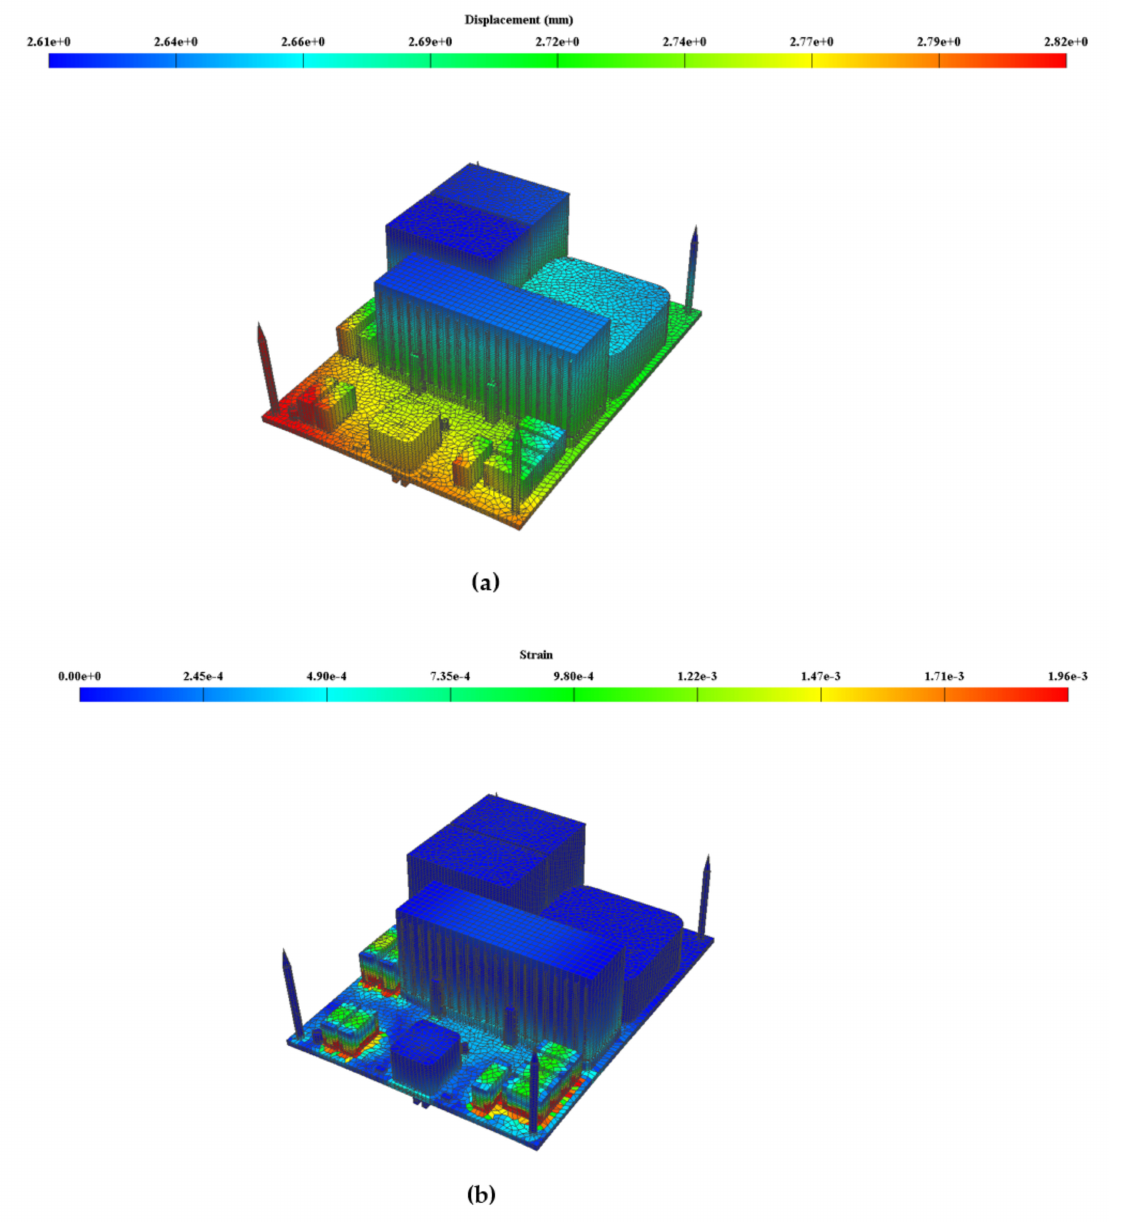
Figure 8. The impact of a thermal mechanical event on the PCB. ( a ) Event displacement at 63 ◦ C. ( b ) Event strain at 63 ◦